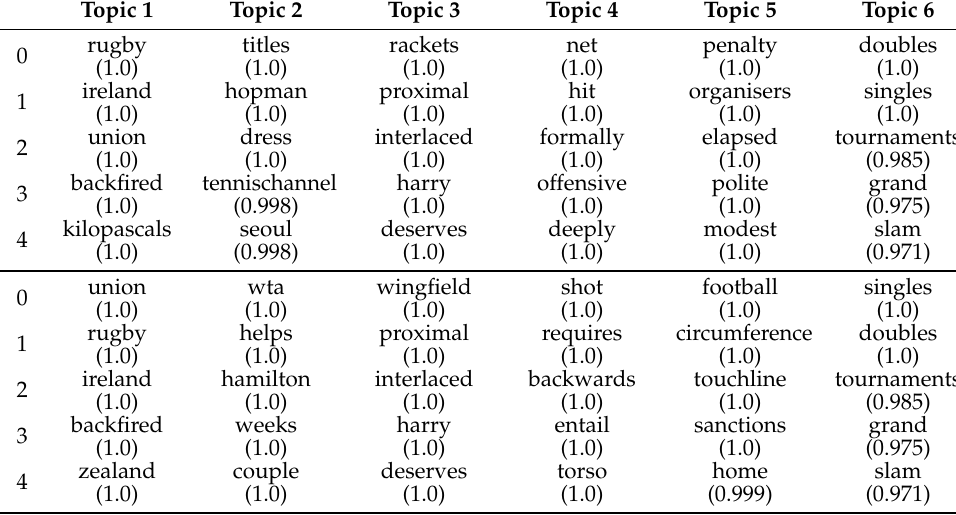
Table A9. For the most significant two words per topic, the four nearest neighbors based on cosine similarity are